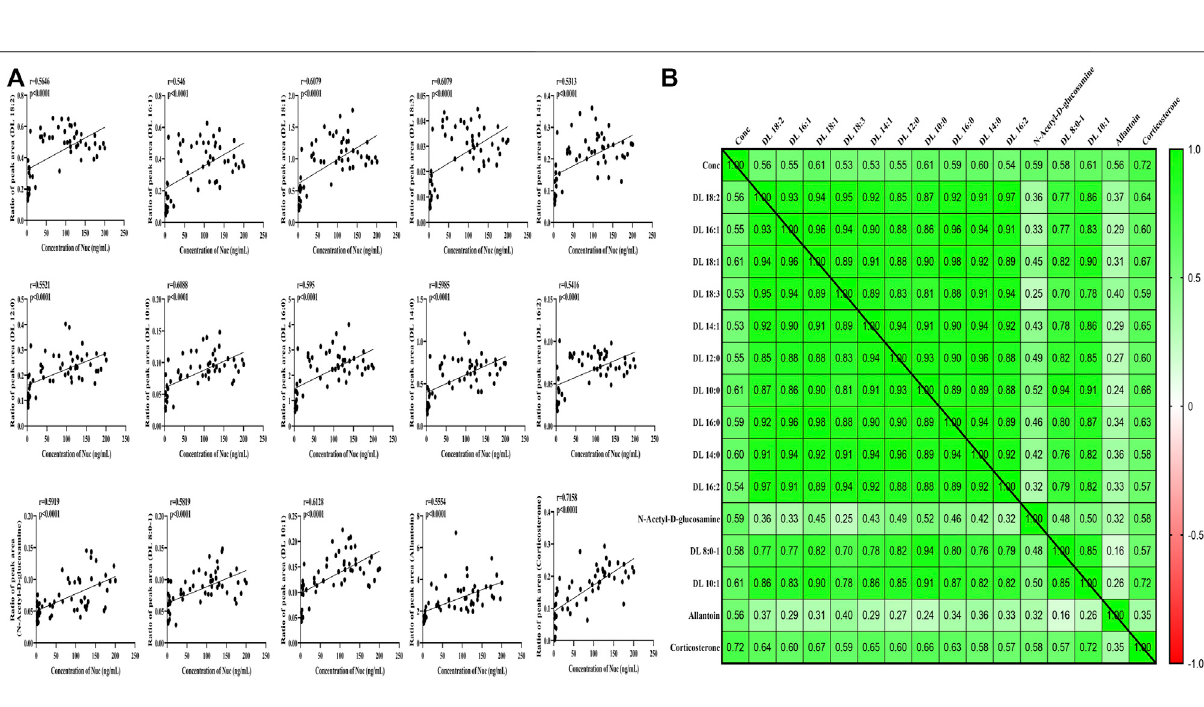
Frontiers in Pharmacology |